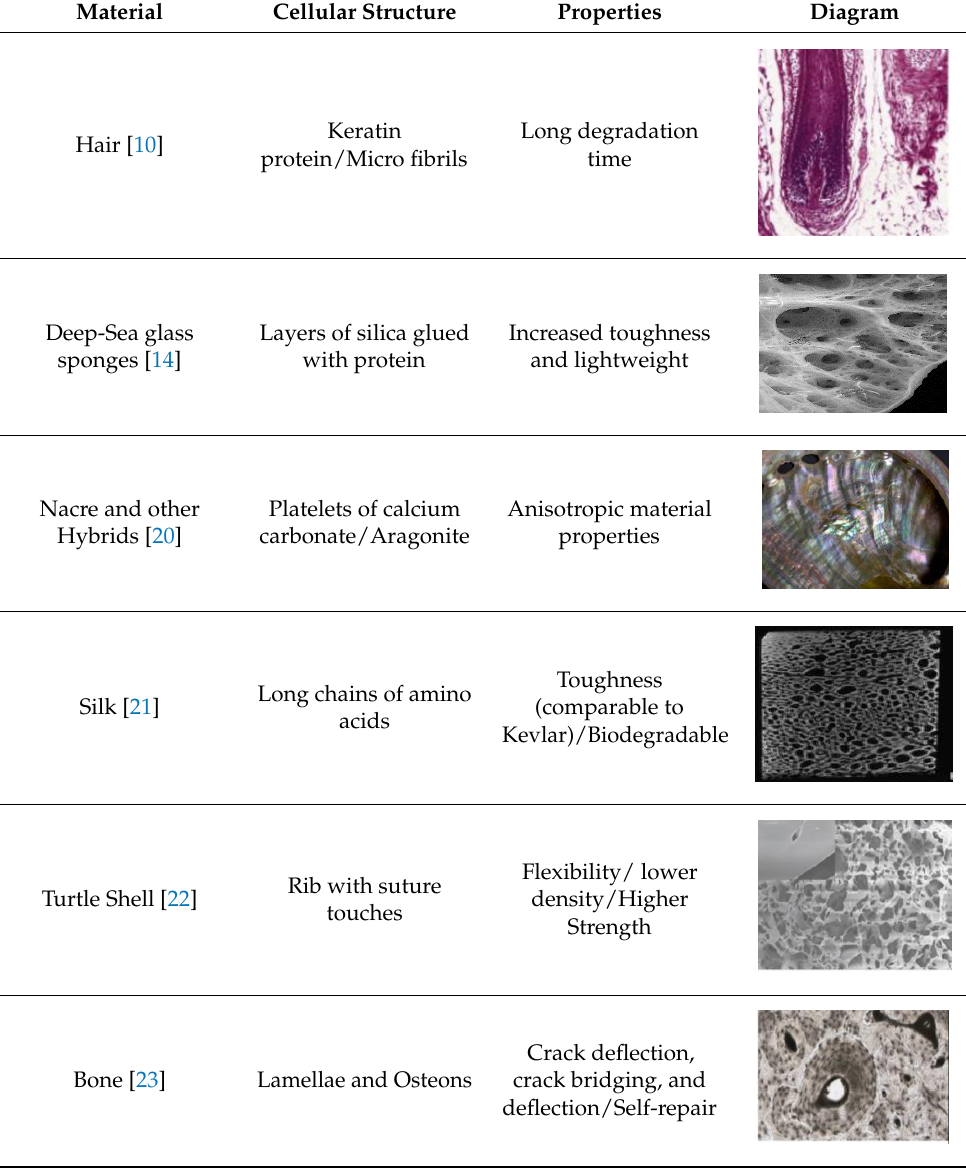
Table 1. Bio-inspired material properties [24].